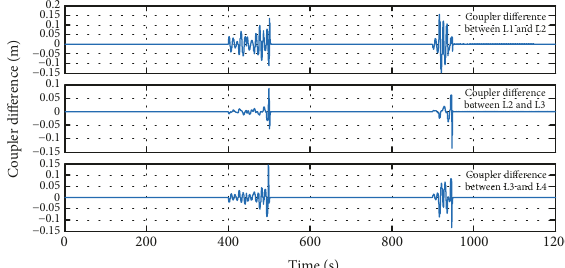
Figure 11: The coupler deformation between neighboring locomo- tives/wagons in Scenario